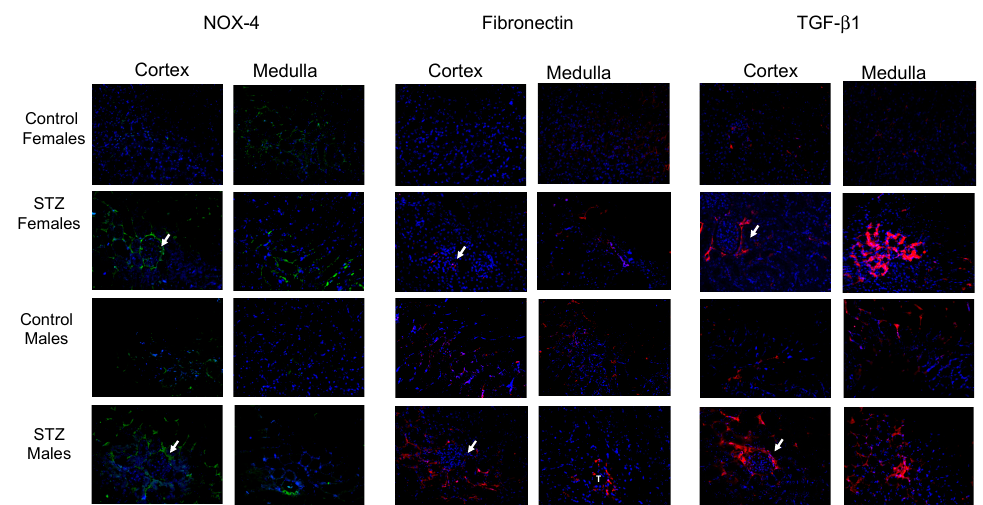
Figure 5. Immunohistochemistry in kidney medullary tissues from control and STZ female and male mice. Arrows indicate glomeruli. After 6 days of single STZ administration, NOX-4 (green color) was significantly augmented in cortical (glomeruli and tubular structures) and medullary tissues (tubular and interstitial structures) from female STZ mice. This was less evident in males. Fibronectin immunostaining was more evident in STZ mice, while TGF- β 1 was more evident in glomeruli and tubular cells in female and male STZ mice compared to controls.